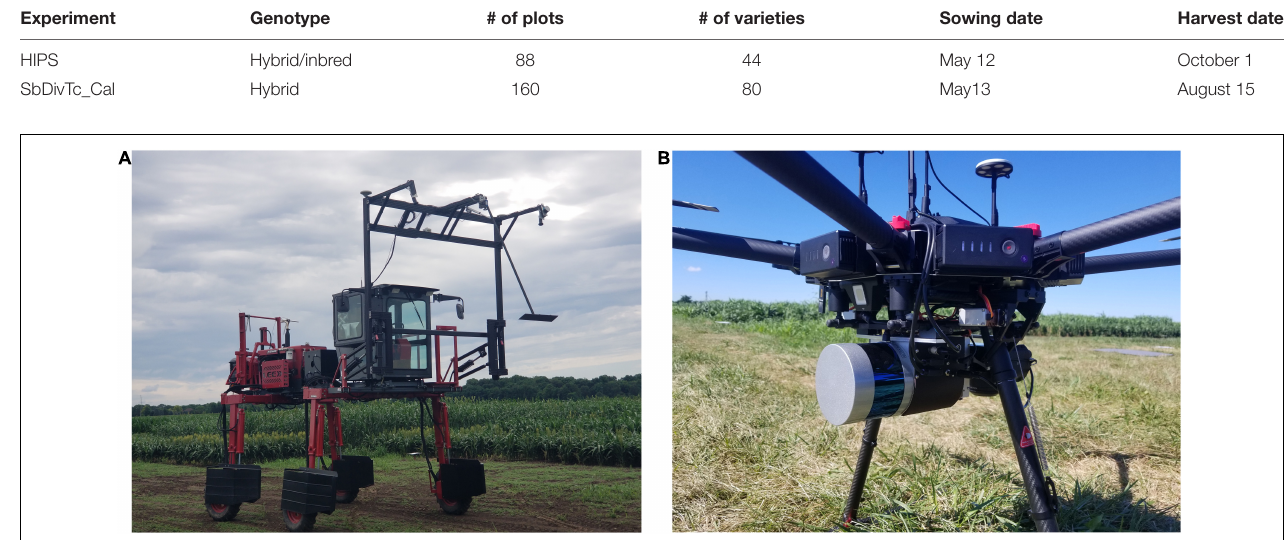
FIGURE 4 | (A) PhenoRover platform with RGB/LiDAR/Hyperspectral/GNSS/INS sensors, (B) UAV-2 with RGB/LiDAR/GNSS/INS sensors in 2020.